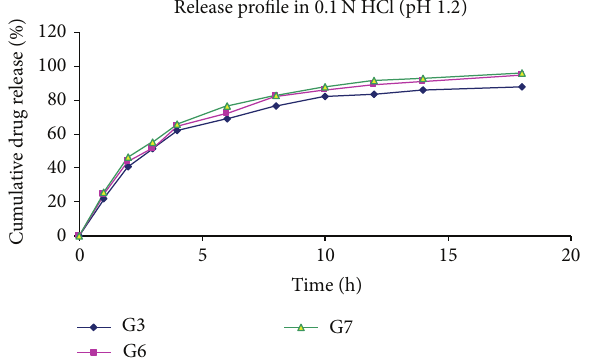
Figure 5: Effect of stirring rate on release profile of drug in 0.1N HCl.